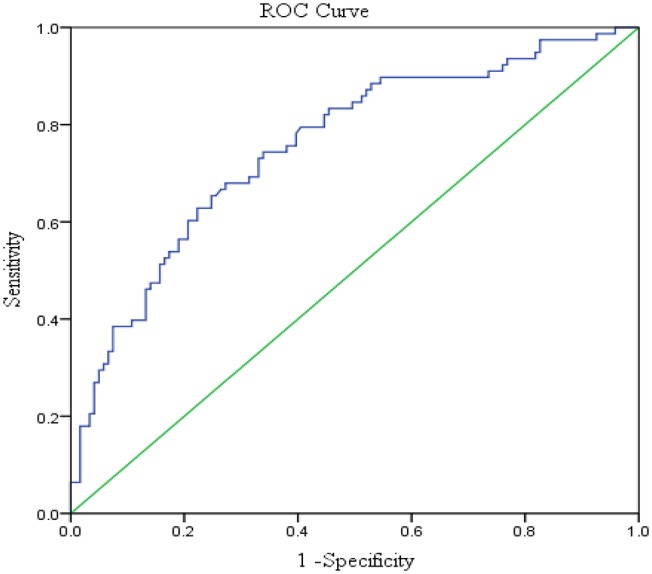
Serum otolin-1 levels provided an area under the curve of 0.757, 95% CI (0.687~0.826) (sensitivity = 67.9%, specificity = 72.7%) for BPPV patients vs. healthy controls.